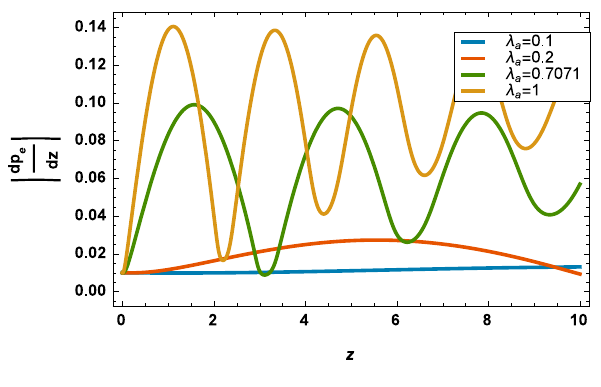
Fig. 4 Pressure Gradient along Straight Tube for Various Values of λ a with α = 20 , β = 0 .